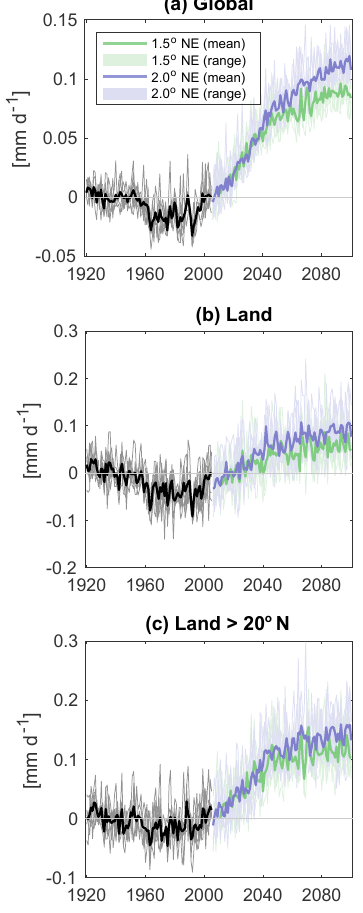
Figure 6. Changes in annual mean precipitation at the (a) global, (b) Land-only and (c) high northern latitude land. Values are relative to the 1921–1960 average. Grey lines show members of the histor- ical CESM ensemble, while black line shows the historical mean. Thin colored lines show individual ensemble members for future scenarios, and the thick bold lines show the ensemble